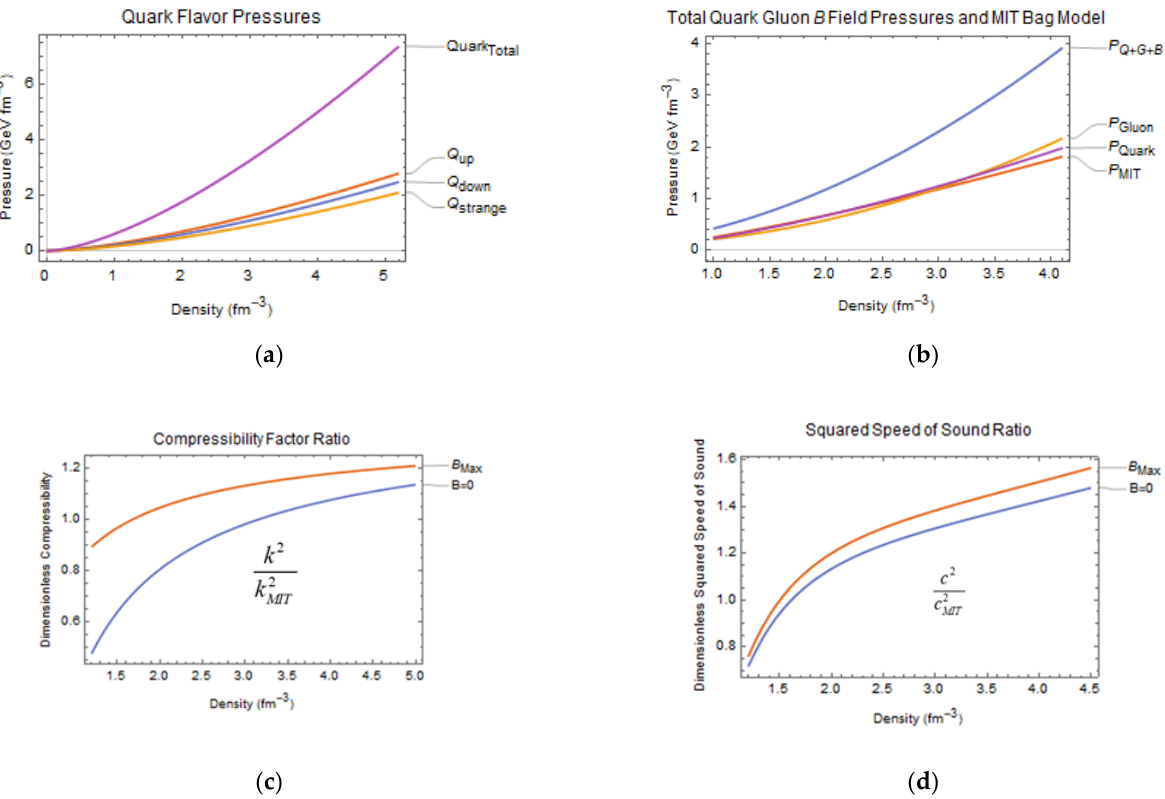
Figure 1. ( a ) Each quark flavor pressure and the total core pressure showing a weak dependence on quark mass values. ( b ) The total quark, gluon and magnetic fields pressures shown with the individual quark, gluon and MIT bag model pressures for a magnetic field at 3.2 × 10 18 G and the bag model constant at 0.38 GeV/fm 3 . ( c ) Compressibility factors expressed as dimensionless ratios compared to the MIT bag model with a vacuum bag constant of 0.2 GeV/fm 3 for no magnetic field and for the maximum field of 3.2 × 10 18 G, ( d ) dimensionless squared speed compared to the MIT bag model for the case of no magnetic field and the same bag constant and for the case of the maximum magnetic field of 3.2 × 10 18 G as a function of core density.